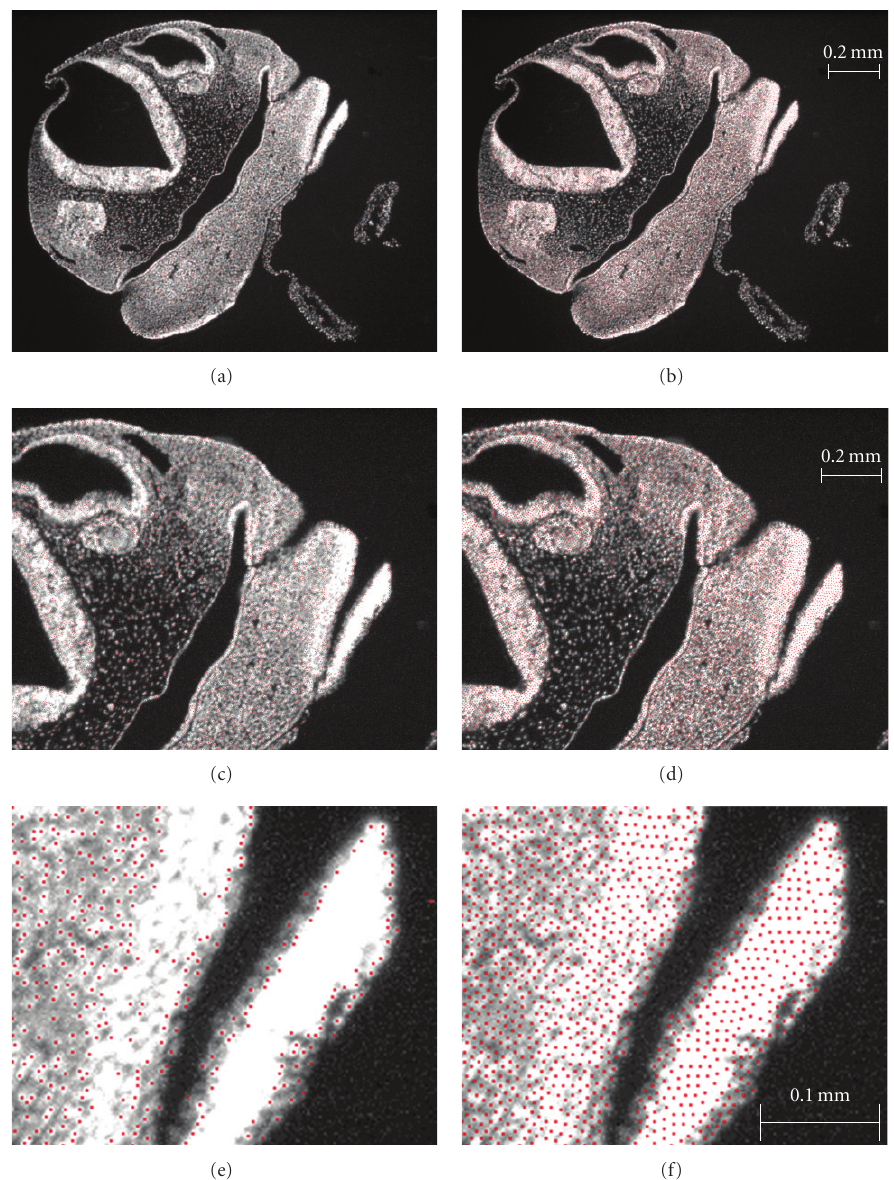
Figure 11: Estimates under saturated fluorescence. Comparison of cell counts estimates in regions with saturated fluorescence. Figures (a) and (b) show the original images produced by ITCN (a) and ICS (b). These images are of high resolution; thus, (c) and (e) show magnified views of ITCN, whereas (d) and (f) show magnified views from ICS. The red markers in (e) and (f) indicate cell locations identified by the ITCN and ICS, respectively. While ITCN only places markers on the borders of the saturated regions (e), ICS populates these regions by placing location markers according to the input cell diameter average